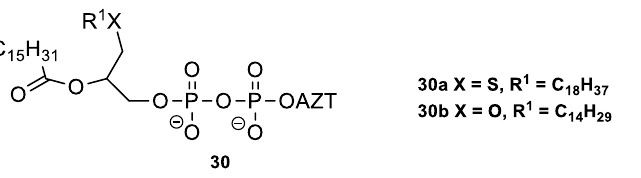
Figure 4. Lipophilic nucleoside diphosphate analogs designed by Hong et al. [102].